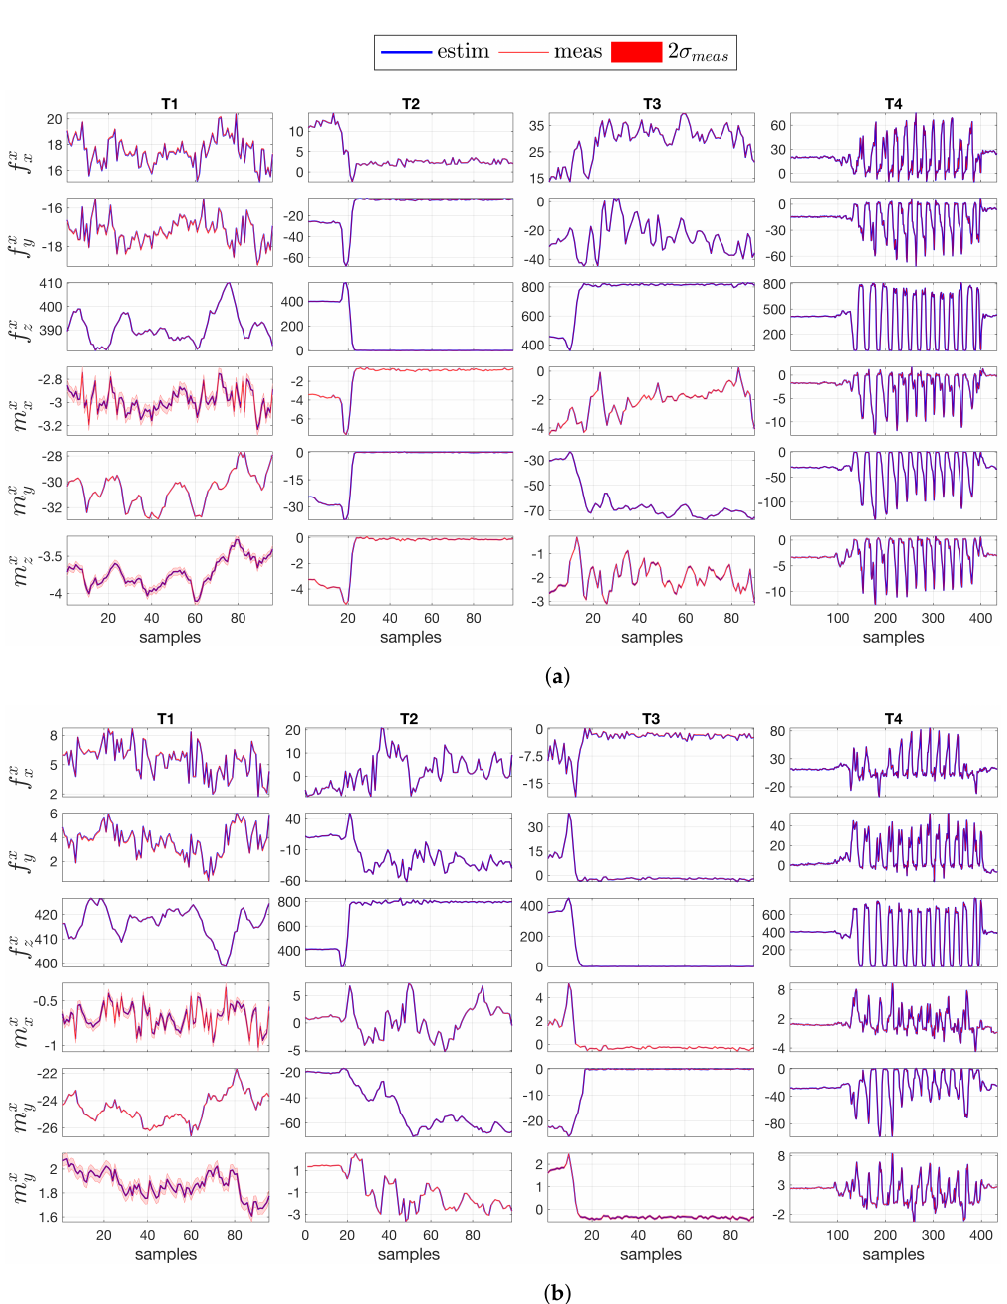
Figure 8. The external force f x [ N] and moment m x [ Nm] comparison between measurement (mean and standard deviation, in red) and estimation via floating-base MAP algorithm (mean, in blue) for ( a ) the left foot and ( b ) the right foot, respectively, for tasks T1, T2, T3 and